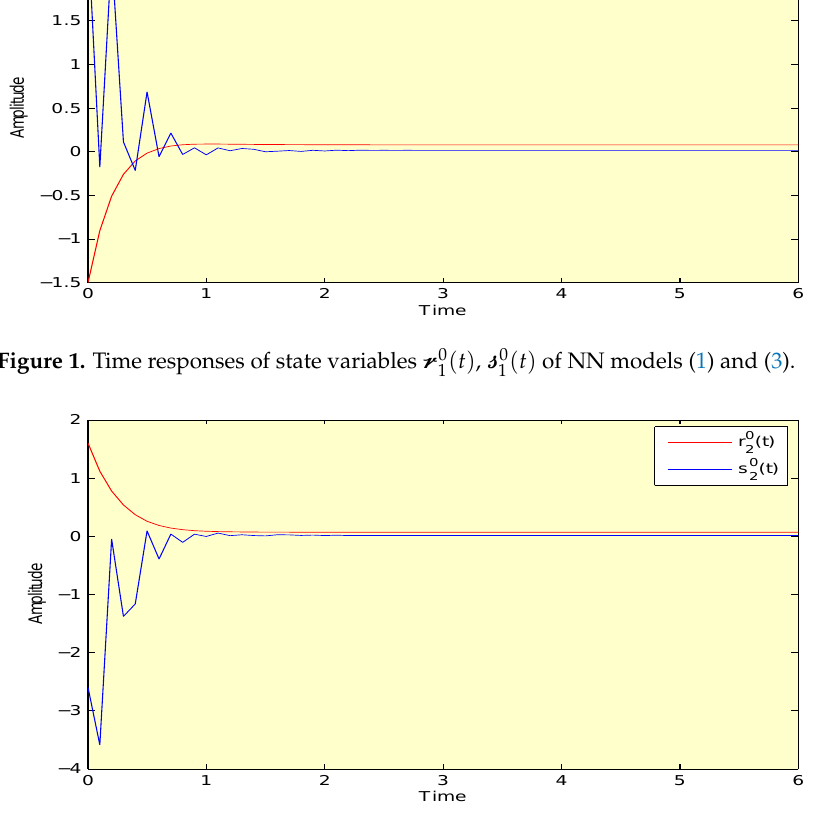
Figure 2. Time responses of state variables (cid:114) 0